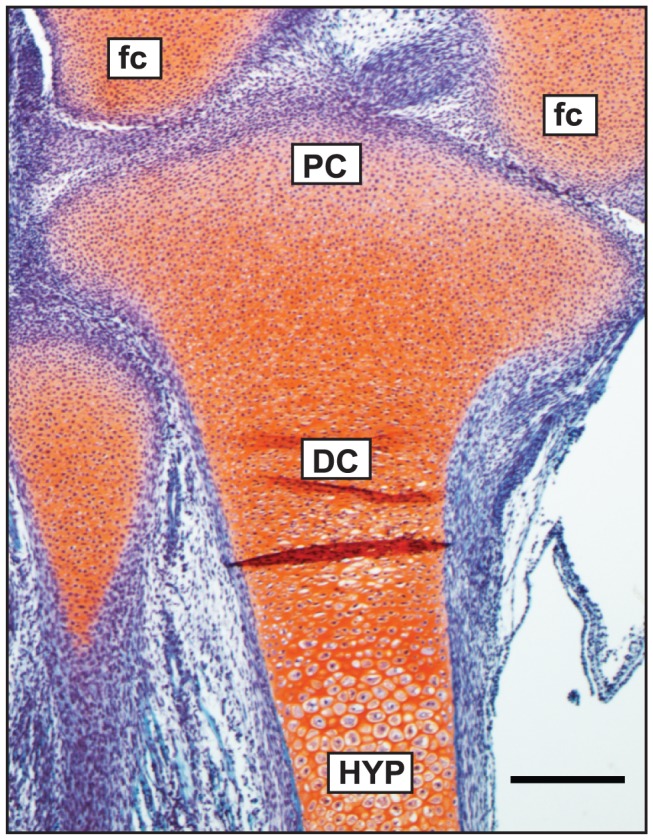
Safranin-O-stained tissue section of a human embryonic developing proximal tibia (gestational day 54).Red-orange staining represents proteoglycans in the developing cartilage extracellular matrix. This stage of development is prior to endochondral ossification. Chondrocytes at various stages of differentiation are present at this stage: precursor chondrocytes (PC) are found at the most proximal end of the developing tibia as well as in the surrounding perichondrium; differentiated chondrocytes (DC) are located further down the developing limb and are distinguishable by their cuboidal or flattened phenotype, depending on their location; hypertrophic chondrocytes (HYP) are terminally-differentiated cells easily distinguished by their increased size. Also shown in this image are the developing femoral condyles (fc) of the distal femur. Scale bar = 250 µm.